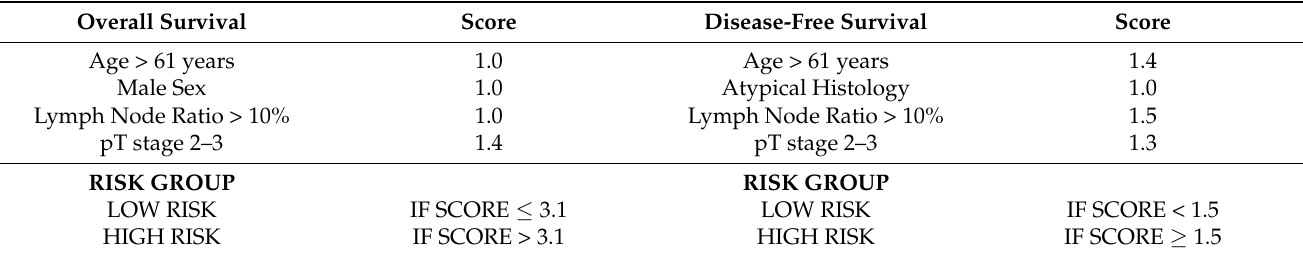
Table 1. Prognostic scores for overall and disease-free